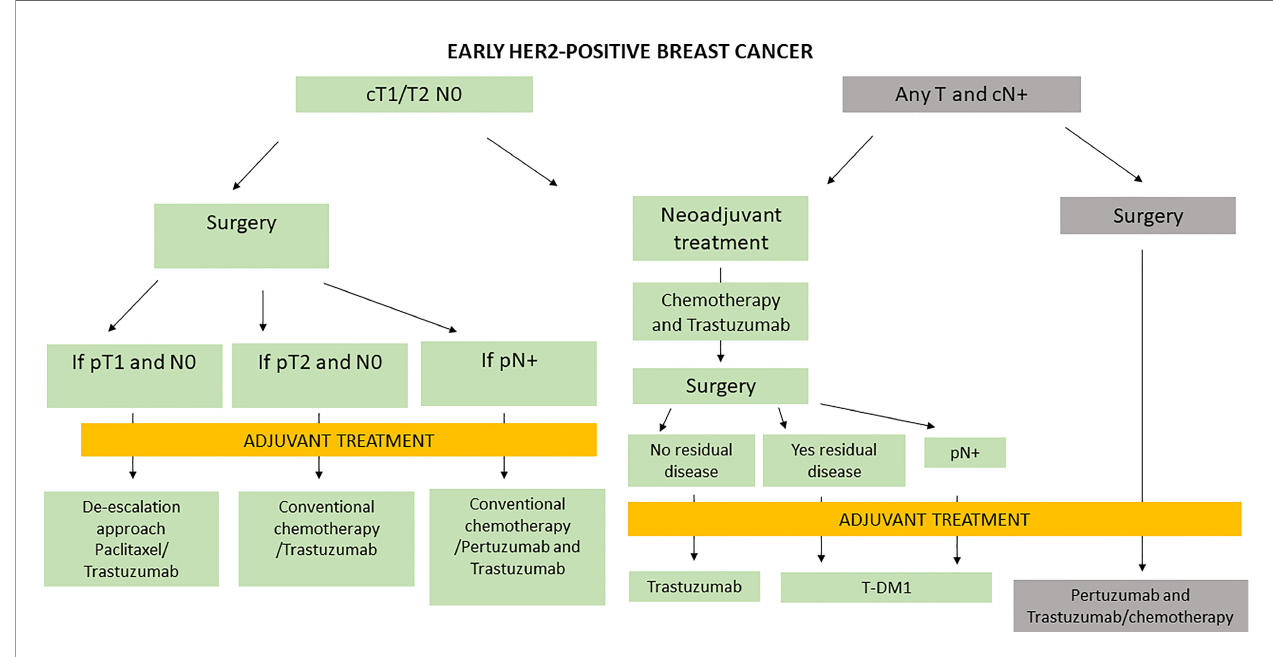
FIGURE 1 | Management of early HER2-positive BC in Italy.